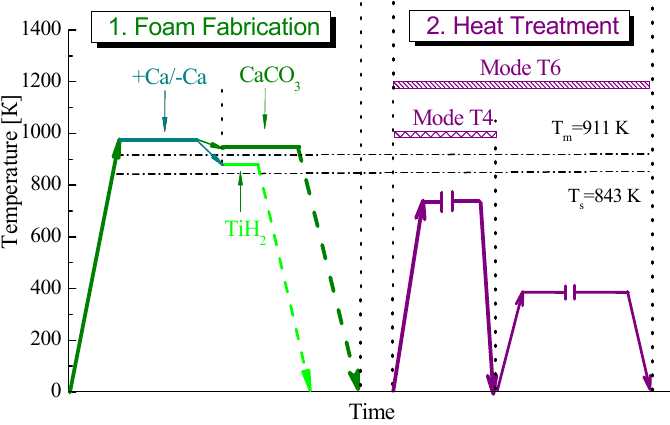
Figure 7. Schematic presentation of temperature-time history of foam